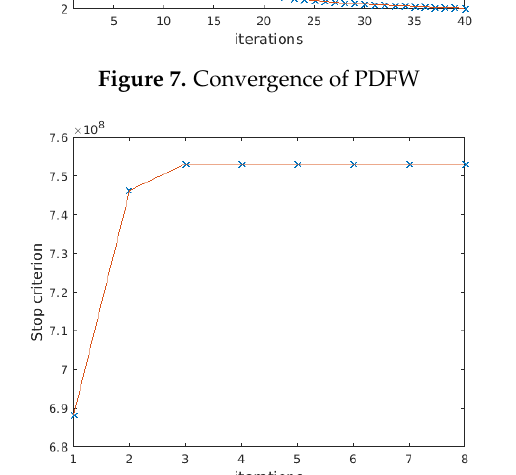
Figure 8. Convergence of